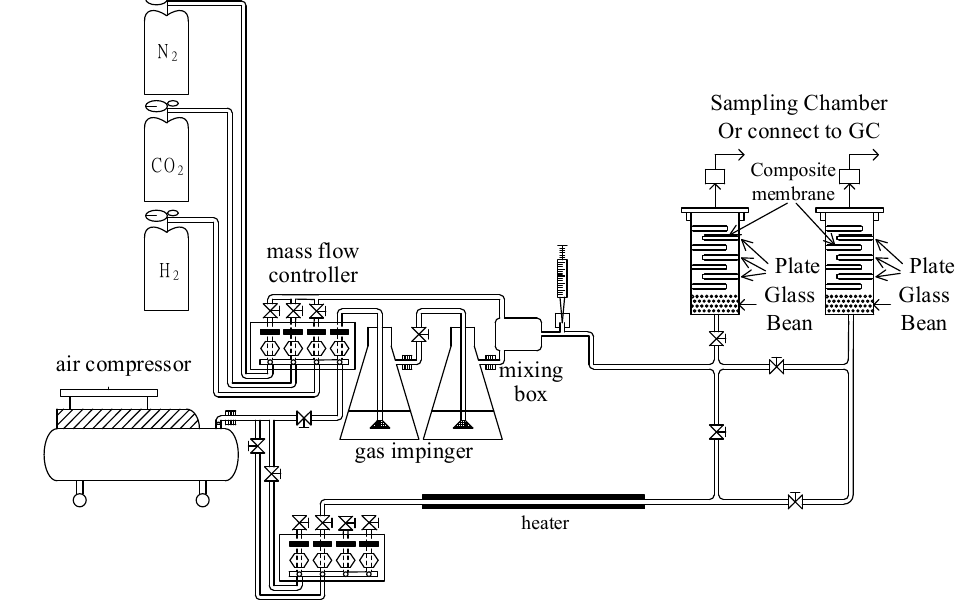
Figure 1. The twin-tower adsorption system in this study.